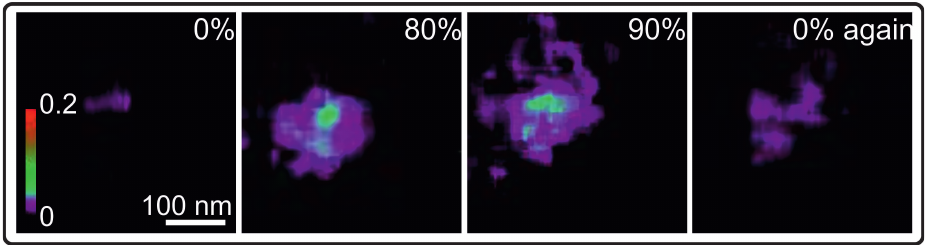
Fig. 11. Absorption maps of an individual unprocessed EURO 2 transporter combustion particle measured at 280eV, at 0, 80, 90 and then returning again to 0% RH.